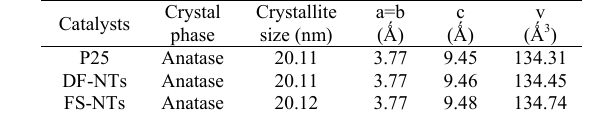
Table 1. Phase, crystal size and lattice parameters of the prepared catalysts